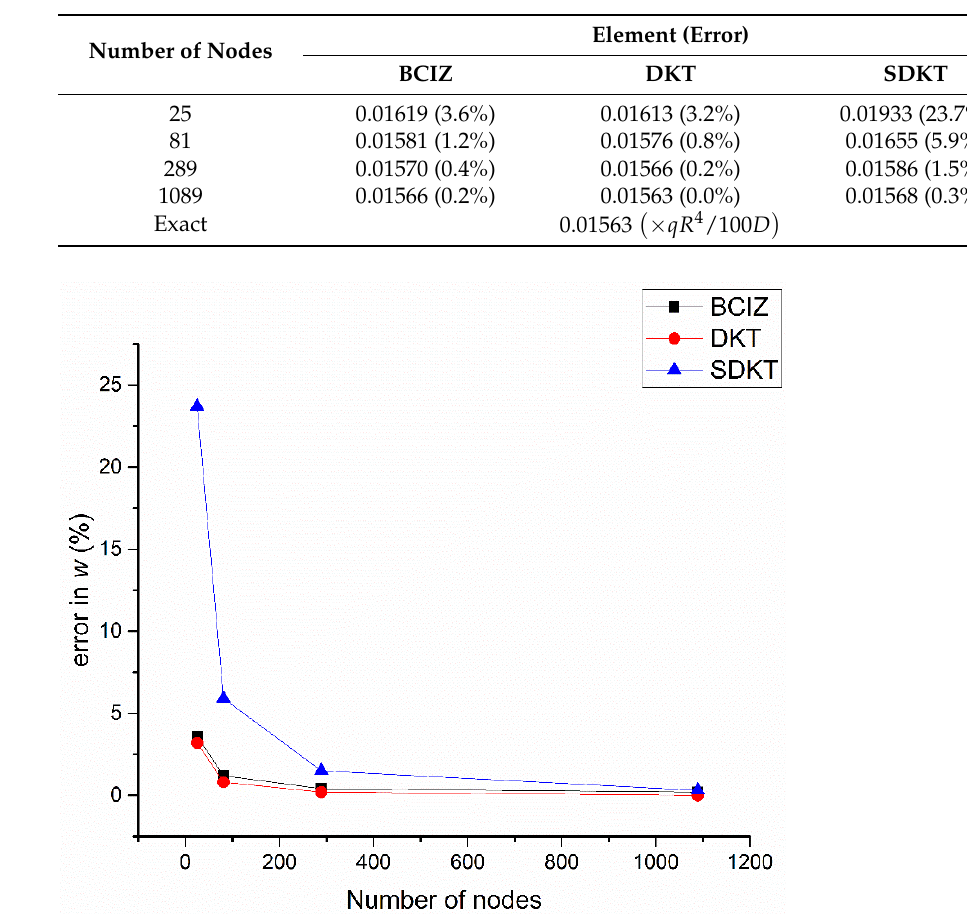
Figure 12. Error of central deflection for a clamped circular plate under uniform load.